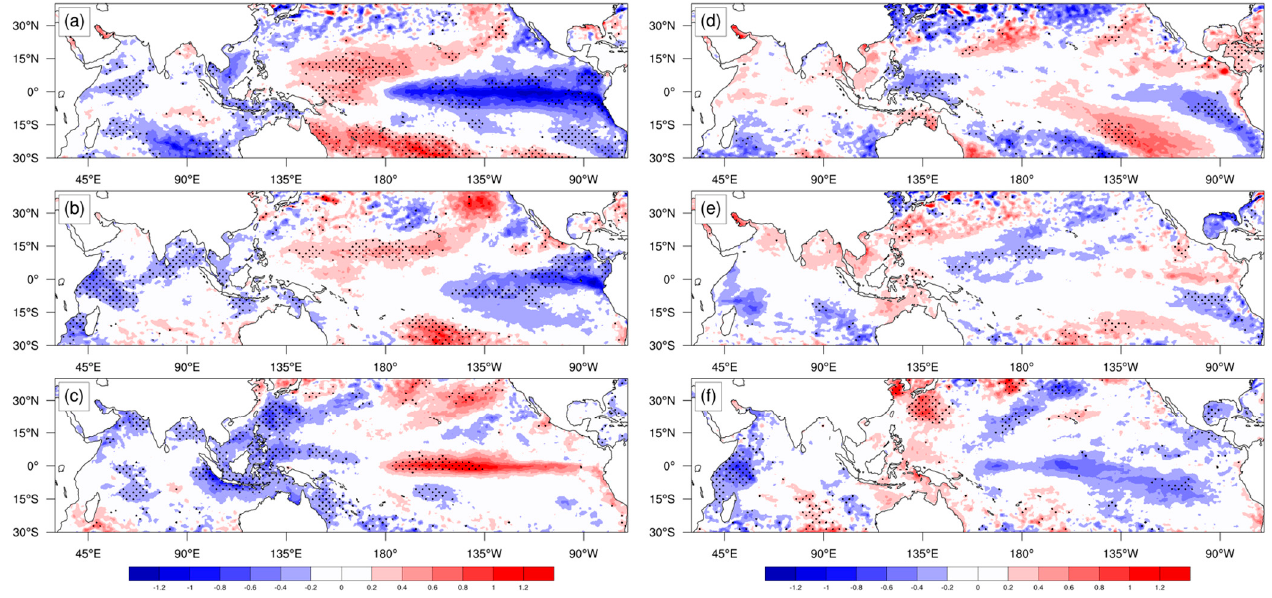
Figure 9. Composite differences of SSTA (unit: K) between wet and dry years ( a , d )/( b , e )/( c , f ) for pre-winter (DJF)/spring (MAM)/summer (JAS); ( a – c )/( d – f ) for S1/S2; dots indicate the regions exceeding 95% confidence level).